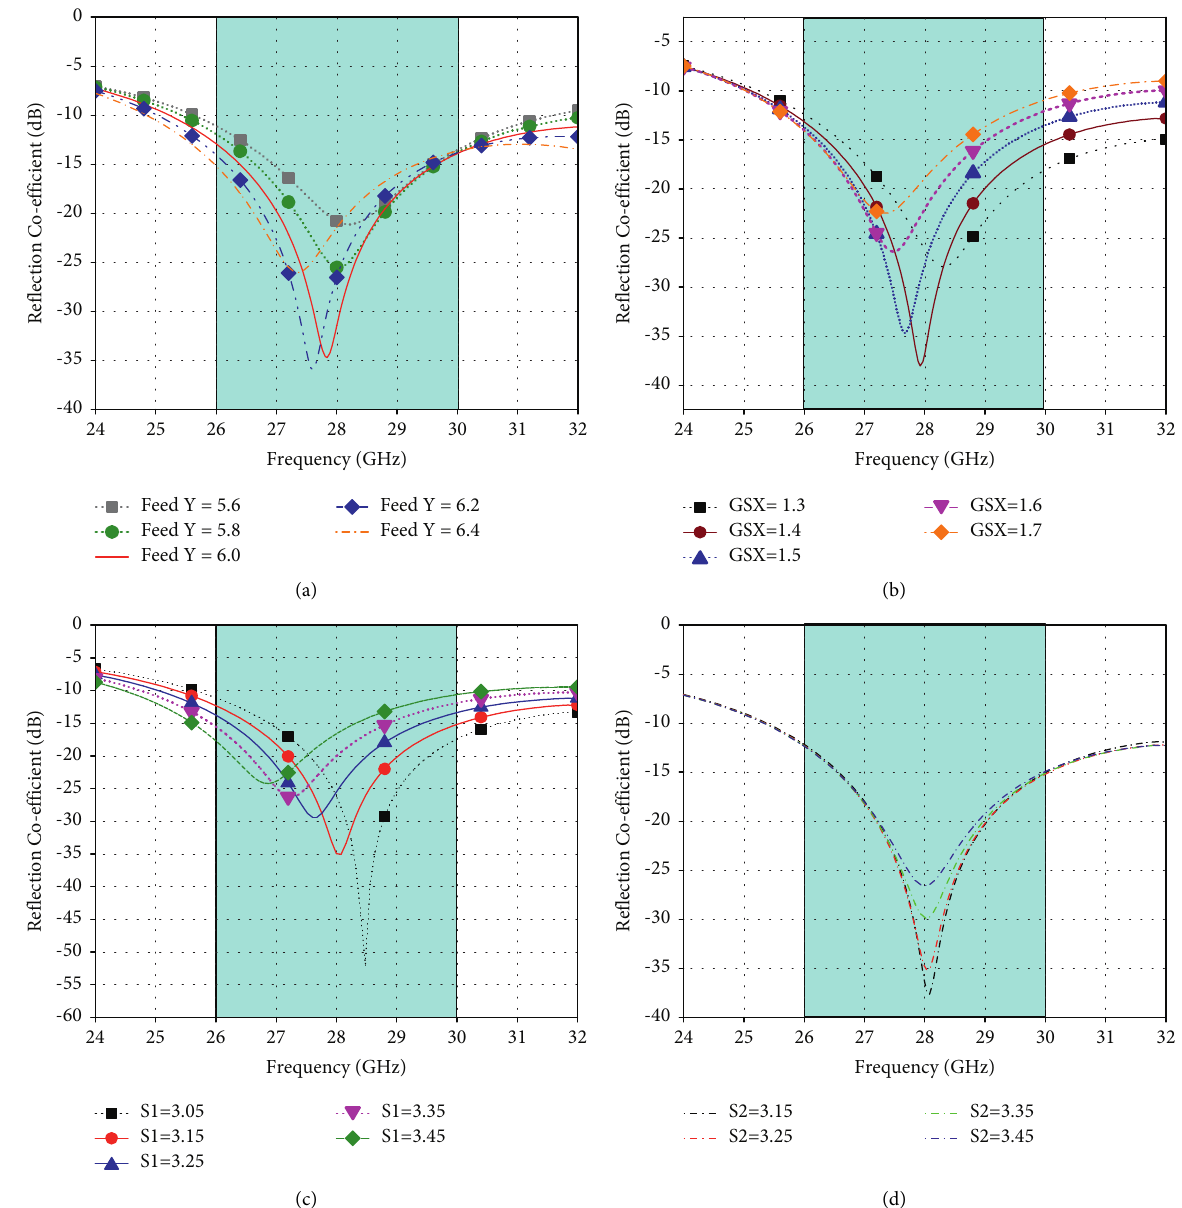
Figure 3: Parametric analysis with respect to (a) FY, (b) GSX, (c) S 1, and (d) S